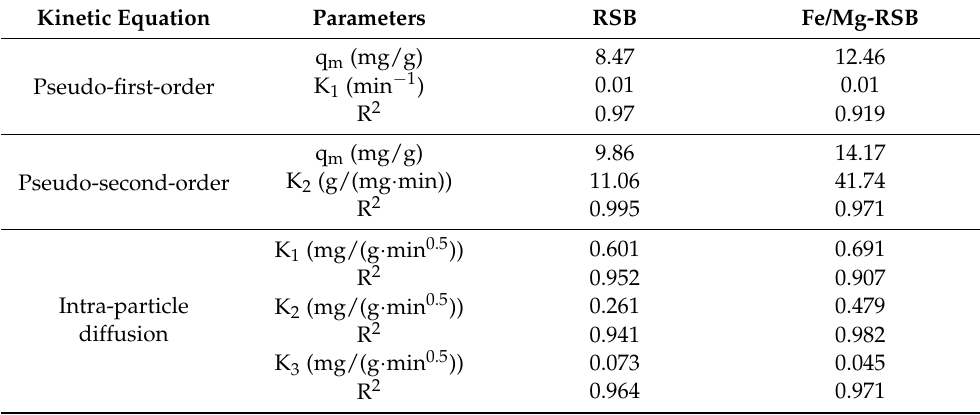
Table 1. Adsorption kinetic parameters for CQP on